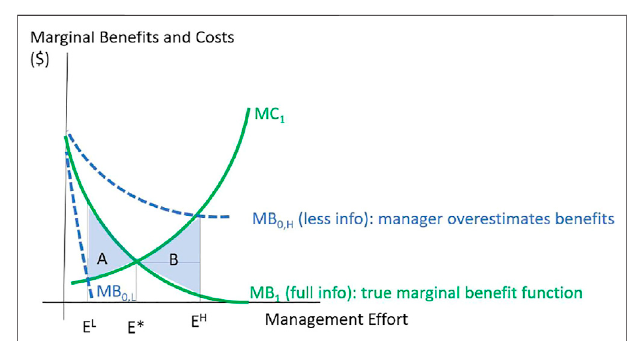
FIGURE 2 | Marginal bene fi t and marginal cost